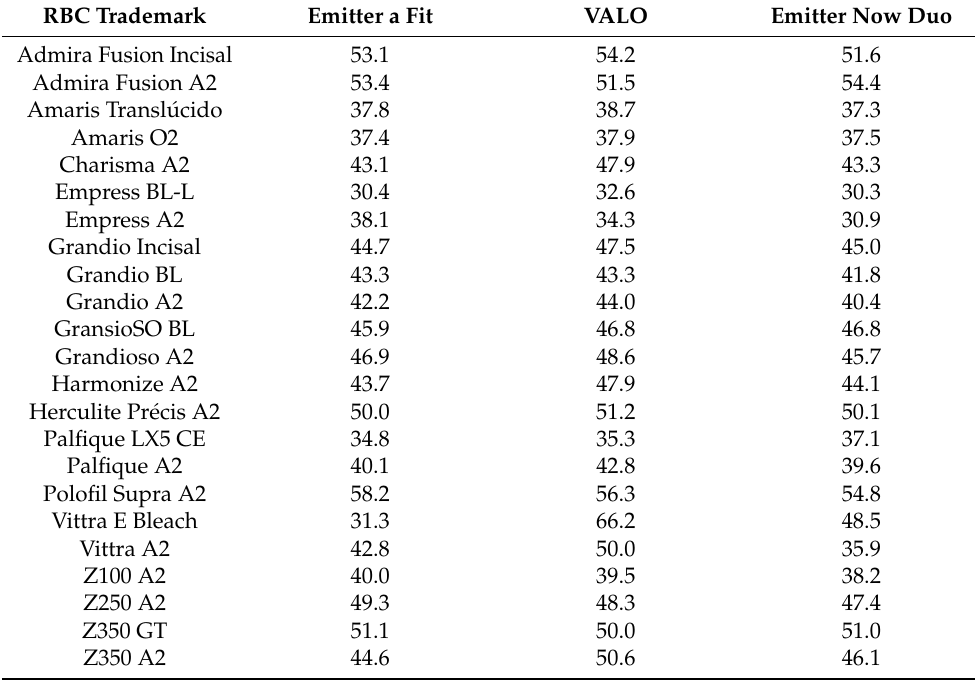
Table 8. Degree of conversion (%) of each RBC, according to the curing